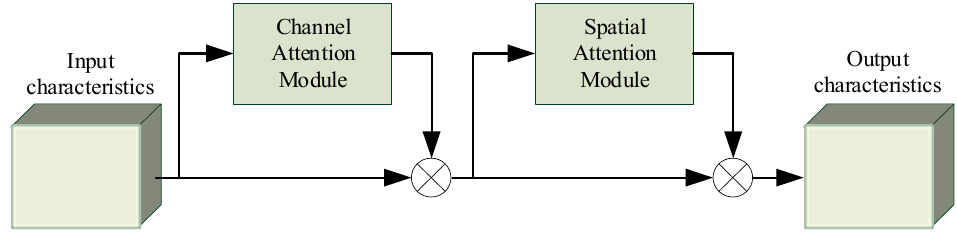
Figure 4. Basic structure of CBAM.